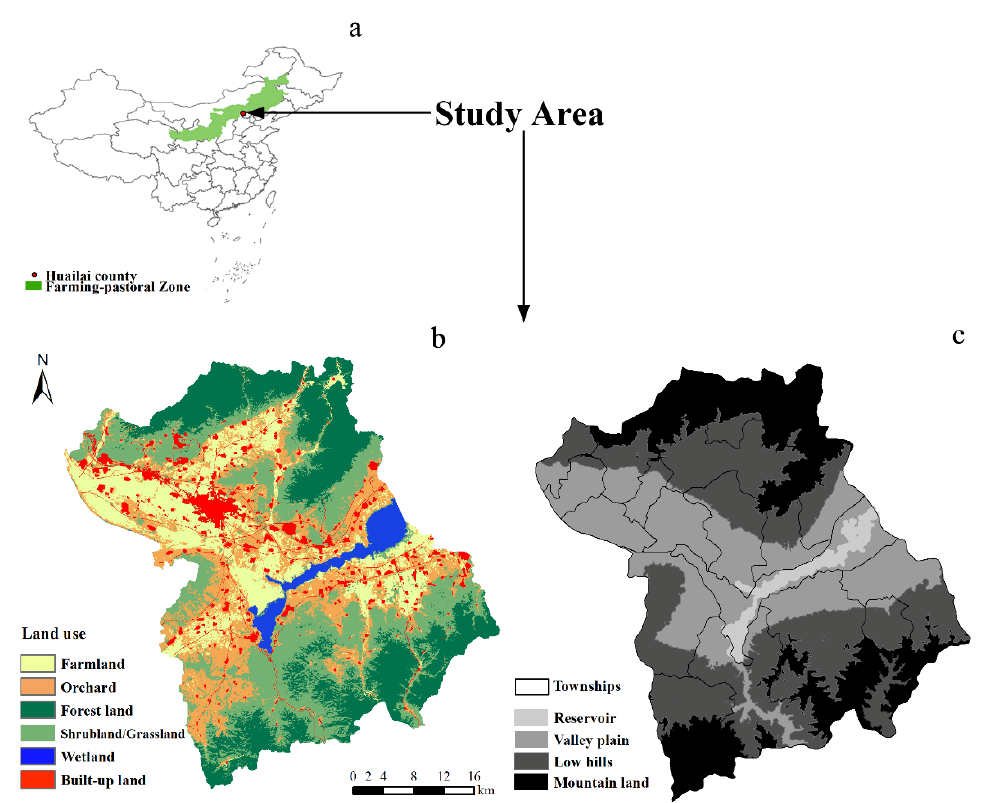
Figure 1. Location of ( a ) farming pastoral zone, ( b ) land use type, and ( c ) Huailai mountain-basin area.